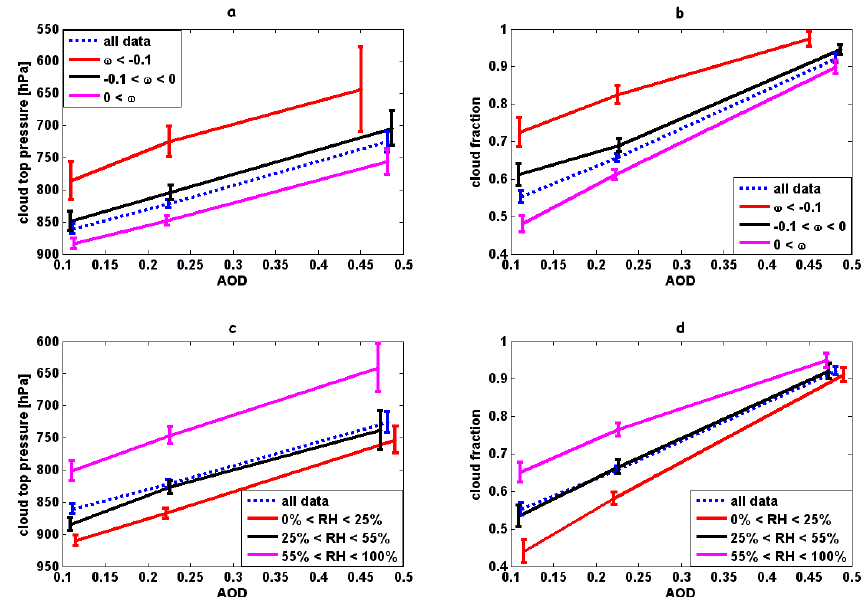
Fig. 10. MODIS cloud properties plotted as a function of AOD restricted by ω (550hPa) and RH (350hPa). The ω subsets are all in [Pa/s] and divided as following: blue – all data, red ω < − 0.1, black − 0.1 < ω < 0 and magenta 0 < ω . The RH subsets are: blue – all data, red 0% < RH < 25%, black 25% < RH < 55% and magenta RH > 55%. (a) CTP vs. AOD for ω subsets, (b) CFR vs. AOD for ω subsets, (c) CTP vs. AOD for RH subsets and (d) CFR vs. AOD for RH subsets. Note how close to parallel the relationships are (more so for the CTP than for the CFR) suggesting that the meteorology can be separated from aerosol effects. The offset of the lines (along the Y axis) represents the meteorology effect while the slope is attributed to